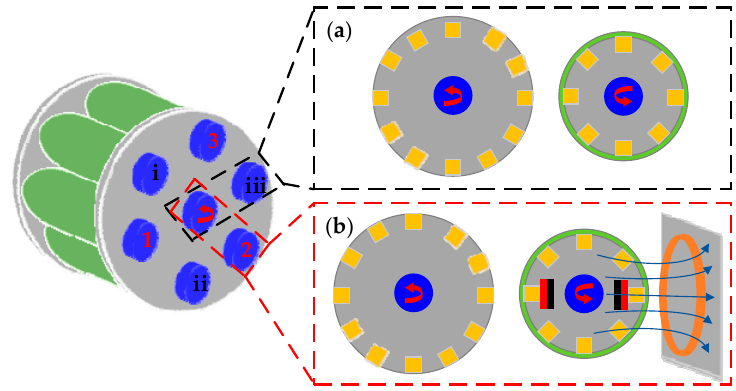
Figure 14. Structure of the designed hybridized generator: ( a ) Triboelectric generator unit; ( b ) Hybrid unit.